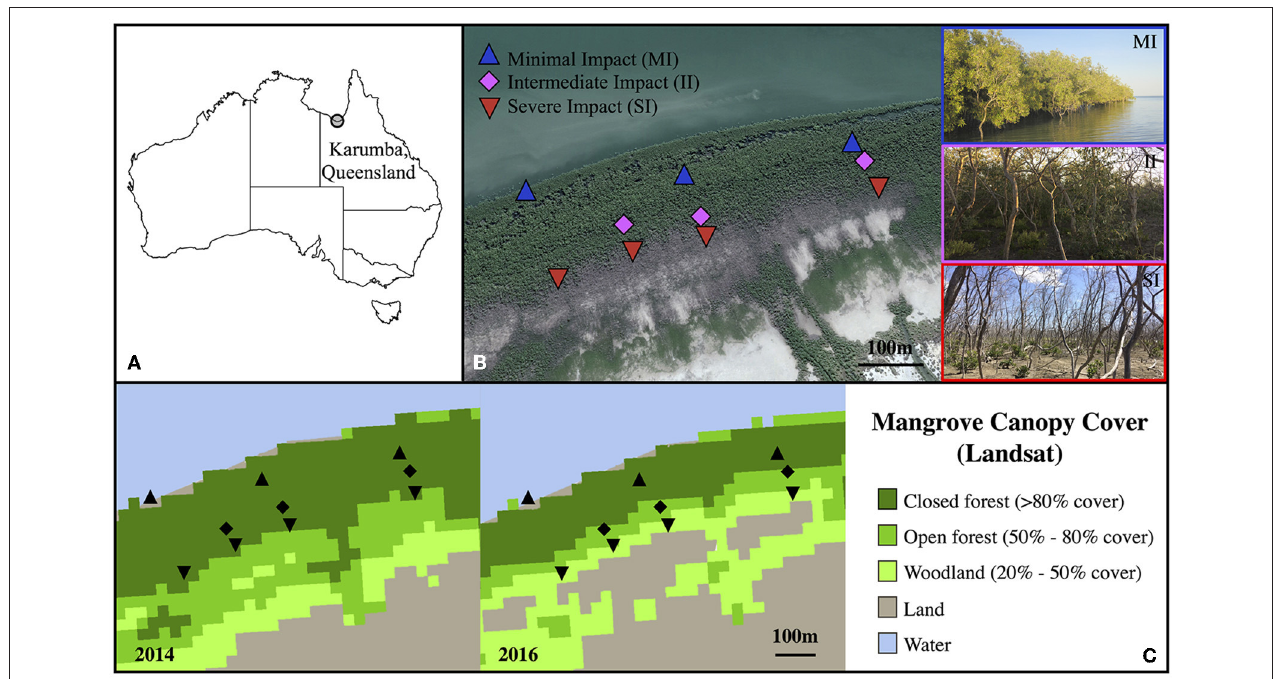
FIGURE 1 | Map showing the field site in Queensland (A) , a detail of transects and sampling sites with pictures (B) and fractional canopy cover of the field site in 2014 and 2016 (C) . In (B) , blue triangles represent sites with minimal impact (MI), magenta diamonds sites with intermediate impact (II) and red inverted triangles sites with severe impact (SI). The satellite image was sourced from Google Earth (dated from May 2017). Pictures, taken in August 2018, illustrate the condition of each zones (blue MI, magenta II and red SI). (C) Fractional canopy cover (FCC) was assessed using the Digital Earth Australia fractional cover archives Mangrove dataset. Black triangles and lozenges represent the 2018 sampling sites location.